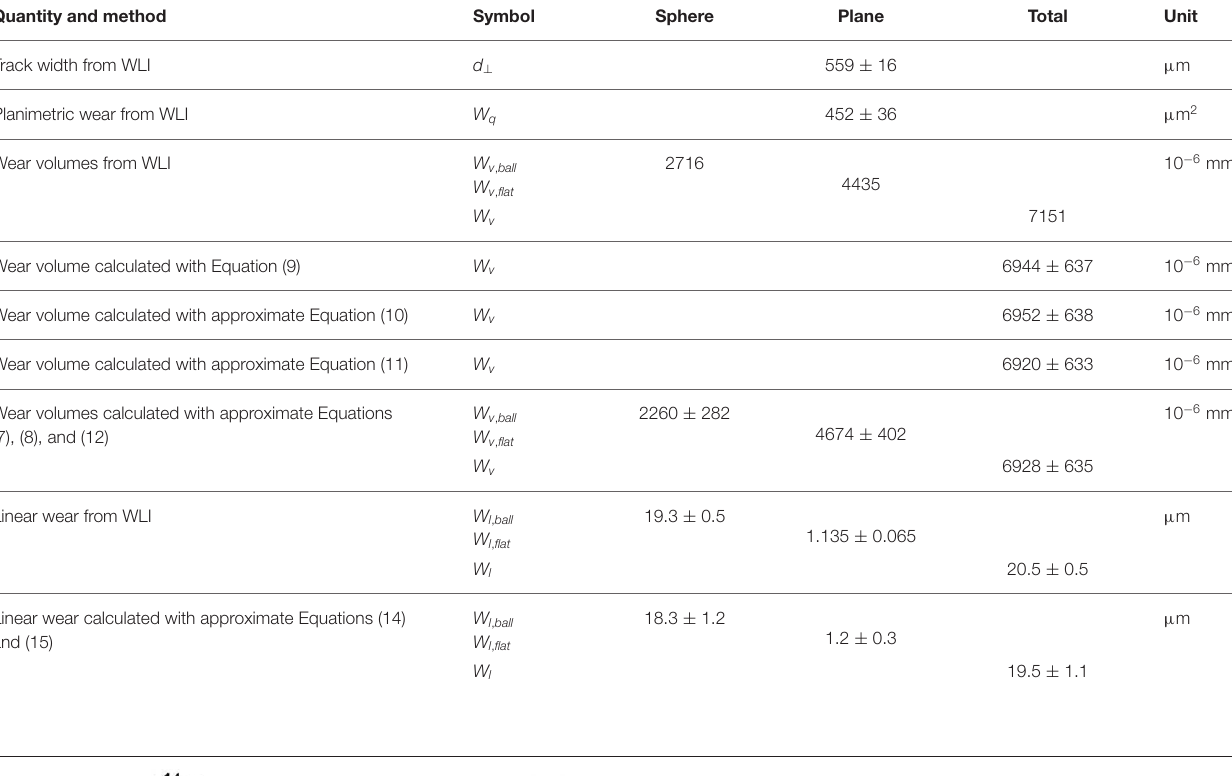
TABLE 1 | Comparison between measured and calculated wear quantities. Quantity and method Symbol